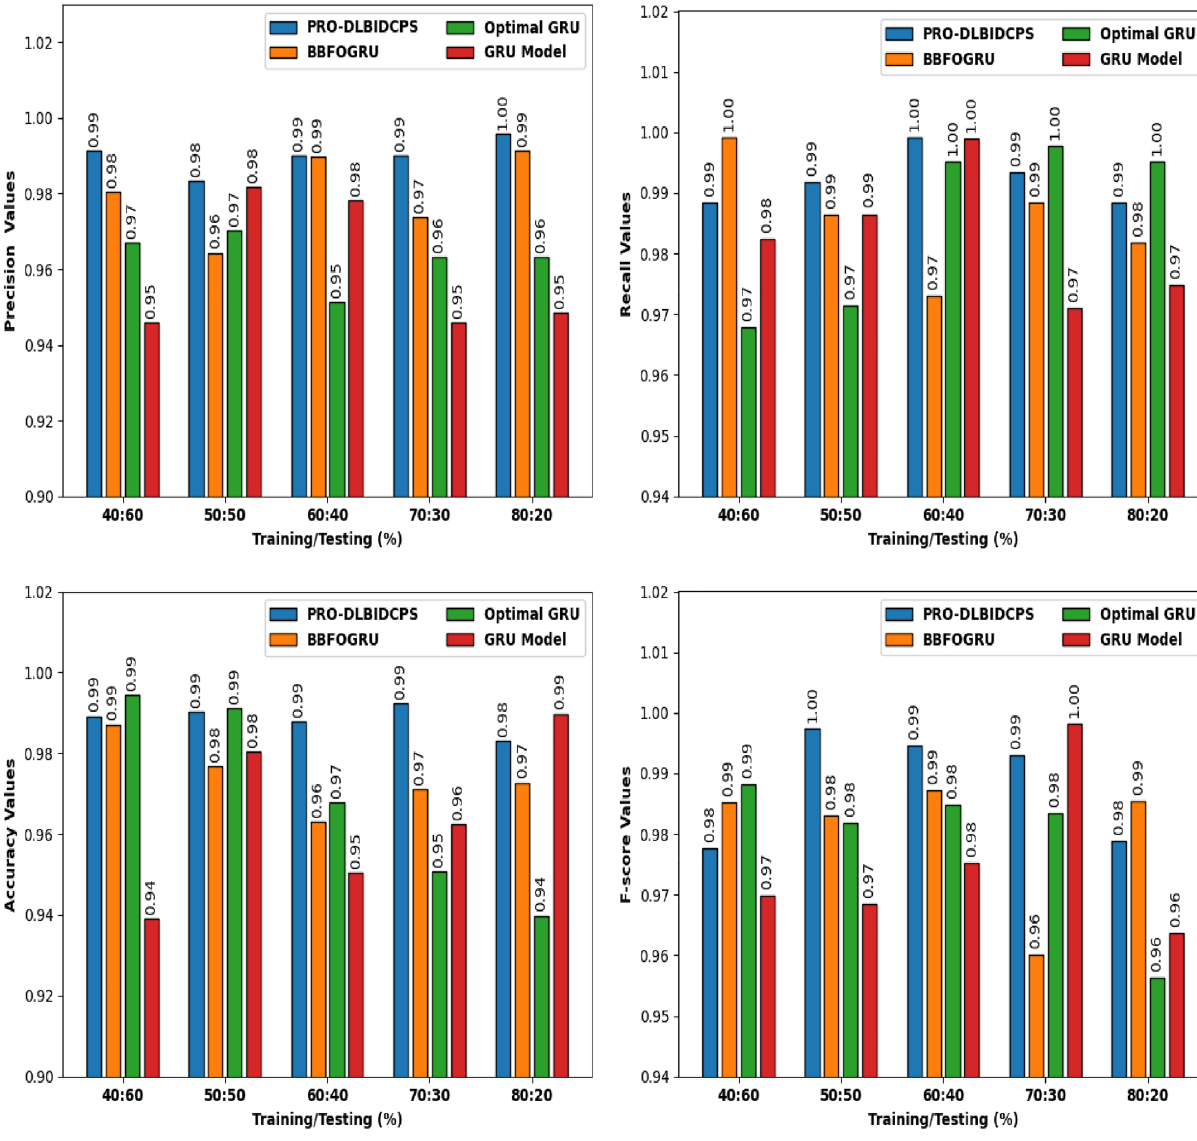
Figure 9. Comparative study of PRO-DLBIDCPS technique CICIDS-2017